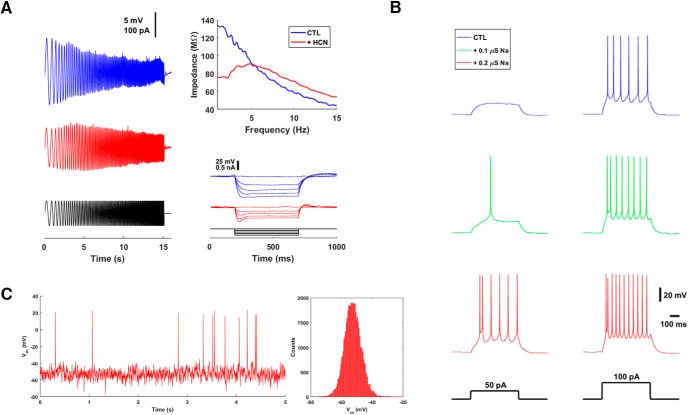
Dynamic clamp recordings from pyramidal neurons in slices of mouse prefrontal cortex. A, HCN conductance. Left, a layer 2/3 pyramidal neuron shows a low pass filtering response (blue) when subjected to a chirp current (black). This is transformed into a bandpass response (red) when 6 nS HCN conductance is added by the dynamic clamp. Upper right, the impedance profiles show this effect quantitatively. Lower right, the neuron also developed a sag potential in response to hyperpolarizing current injections. B, Sodium conductance. Addition of 100 or 200 nS of sodium conductance makes this layer 2/3 pyramidal neuron more excitable in a graded fashion. Shown are the responses to current steps of 50 and 100 pA. C, Synaptic background activity in a layer 5 pyramidal neuron. The point conductance method was used to simulate an in vivo–like state (excitatory mean 3 nS, excitatory standard deviation 1.5 nS, inhibitory mean 6 nS, inhibitory standard deviation 3 nS). At left is a 5-s recording of membrane potential Vm. At right is a histogram of subthreshold membrane potential; the spikes of the 5-s recording were clipped out, and the remainder were used to construct the histogram.